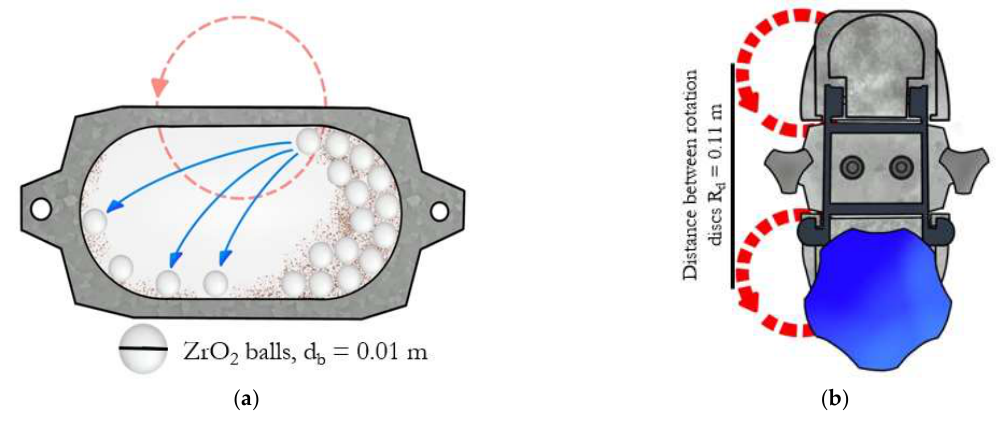
Figure 2. Retch E-max mill: ( a ) Vessel, ( b ) Clamping system. Table 2. Calculated angular speed and deformation energy based on milling parameters.